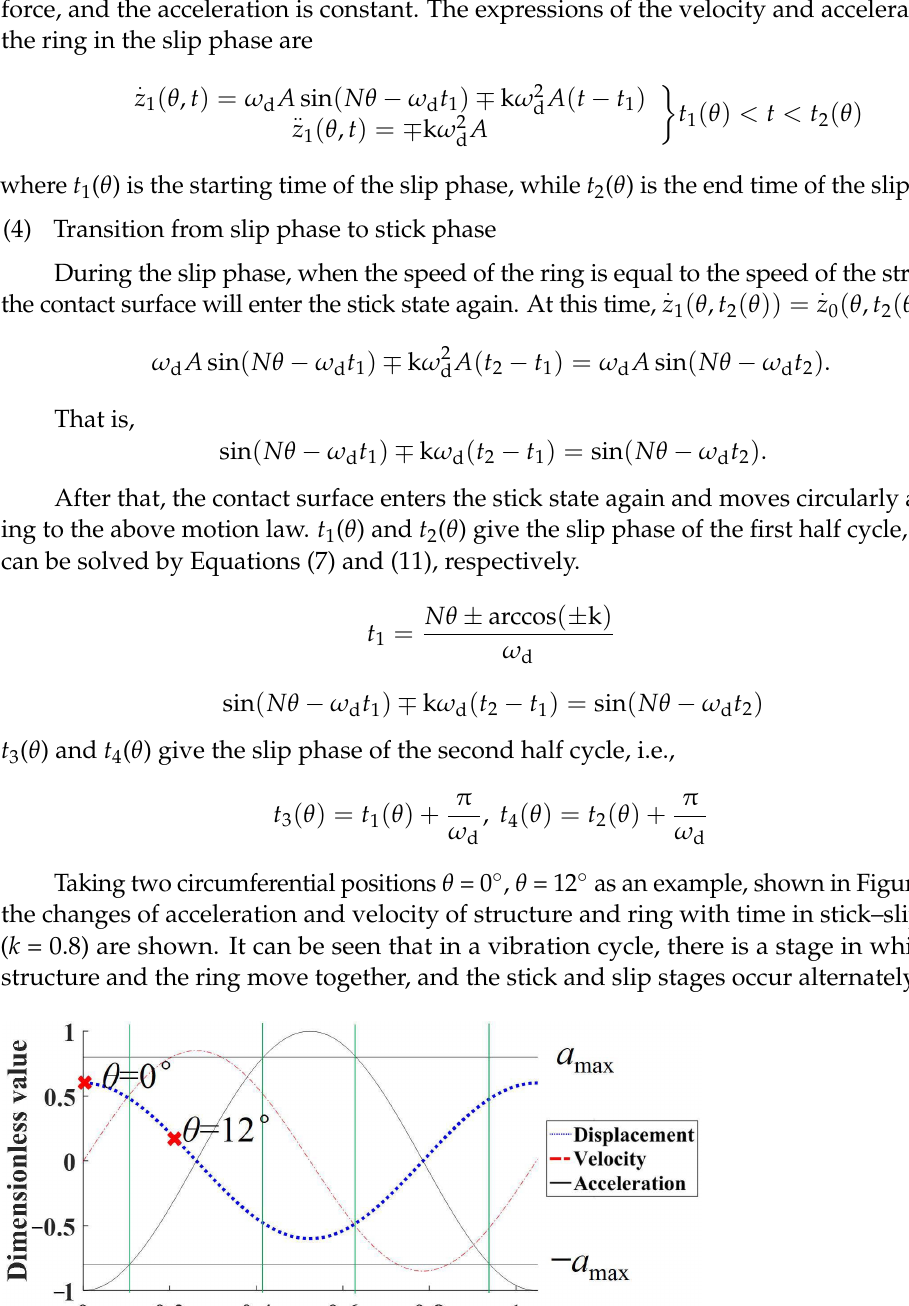
( b ) Figure 6. Motion at θ = 0° in stick–slip state ( k = 0.8): ( a ) Acceleration; ( b ) Velocity. ( a ) ( b ) Figure 7. Motion at θ = 12° in stick–slip state ( k = 0.8): ( a ) Acceleration; ( b ) Velocity. Full ‐ Slip State When the value of parameter k in Equation (7) is small enough that there is no stick phase in the whole vibration cycle, it is called full ‐ slip state. The motion of the slip phase of the ring still satisfies Equation (9), and it can be considered that the starting time and the end time of the stick phase are the same, i.e.,